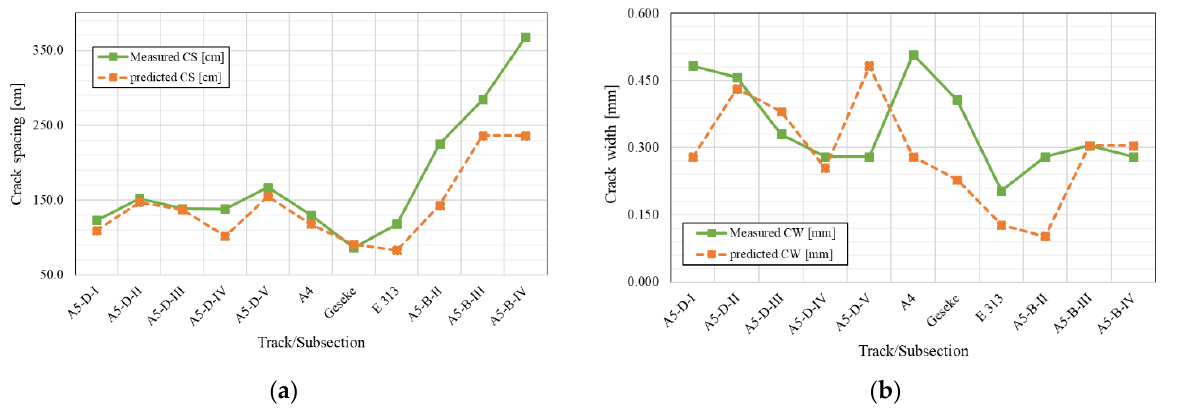
Figure 1. Predicted and measured values for considered tracks/subsections: ( a ) crack spacing [CS]; ( b ) crack width [CW].